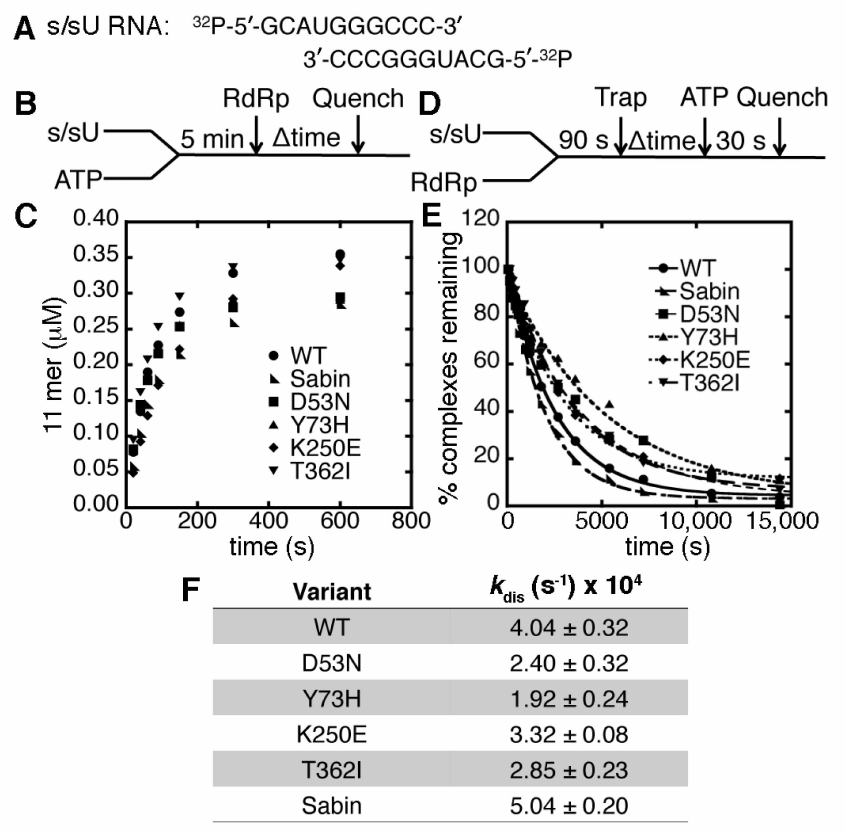
Figure 2. The Sabin amino acid substitutions do not substantially change the association or dissociation of RdRp complexes. ( A ) The s/sU RNA is 32 P-labeled on the 5 1 end for the association and dissociation assays; ( B ) the experimental design for the RdRp-RNA-NTP assembly assay. RNA (0.5 µ M duplex) and 500 µ M ATP ( i.e. , which will template against U) were pre-incubated for 5 min at 30 ˝ C before the addition of 1 µ M RdRp. Reactions were quenched at the indicated times by adding 25 mM EDTA; ( C ) comparisons of the RdRp-RNA-NTP assembly assay for WT ( ), D53N ( (cid:4) ), Y73H ( (cid:78) ), K250E ( (cid:7) ), T362I ( İ ) and Sabin ( ) RdRp. The Sabin I RdRp contains all four amino acid substitutions ( i.e. , D53N, Y73H, K250E and T362I); ( D ) the experimental design for the RdRp-RNAA dissociation assay. RdRp (1 µ M) and RNA (0.1 µ M) were pre-incubated at 30 ˝ C for 90 s before the addition of 100 µ M unlabeled RNA ( i.e. , “trap”). After the indicated times, the reaction buffer was mixed with 500 µ M ATP and then quenched after 30 s by the addition of 25 mM EDTA; ( E ) the RdRp-RNA dissociation assays for WT ( ), D53N ( (cid:4) ), Y73H ( (cid:78) ), K250E ( (cid:7) ), T362I ( İ ) and Sabin ( ) RdRp. The lines represent the data fits to a single exponential function; ( F ) the RdRp-RNA dissociation rate constants derived from the data in panel ( E ). The dissociation rate constants for the RdRp variants are not substantially different from the WT